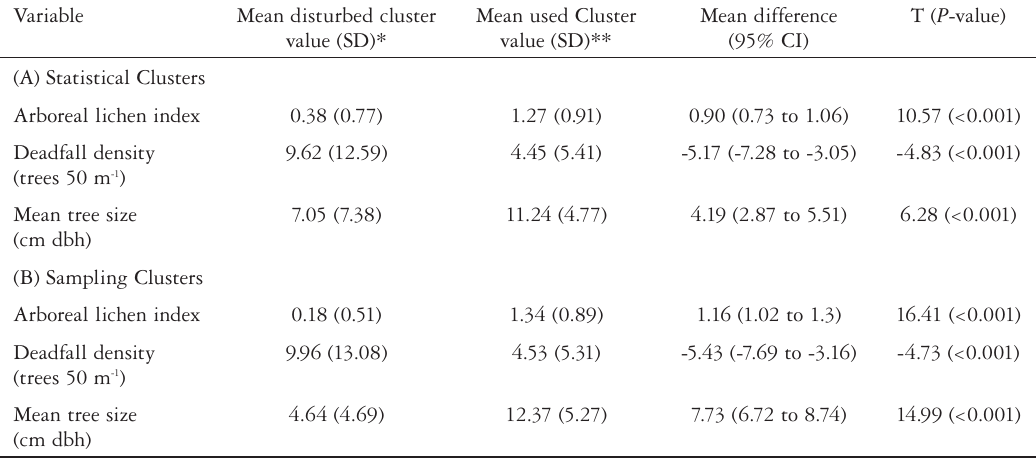
Table 1. Differences between (A) statistical clusters and (B) sampling clusters at the two group level for three key vari- ables determining habitat suitability for caribou in the Naosap range, west-central Manitoba.